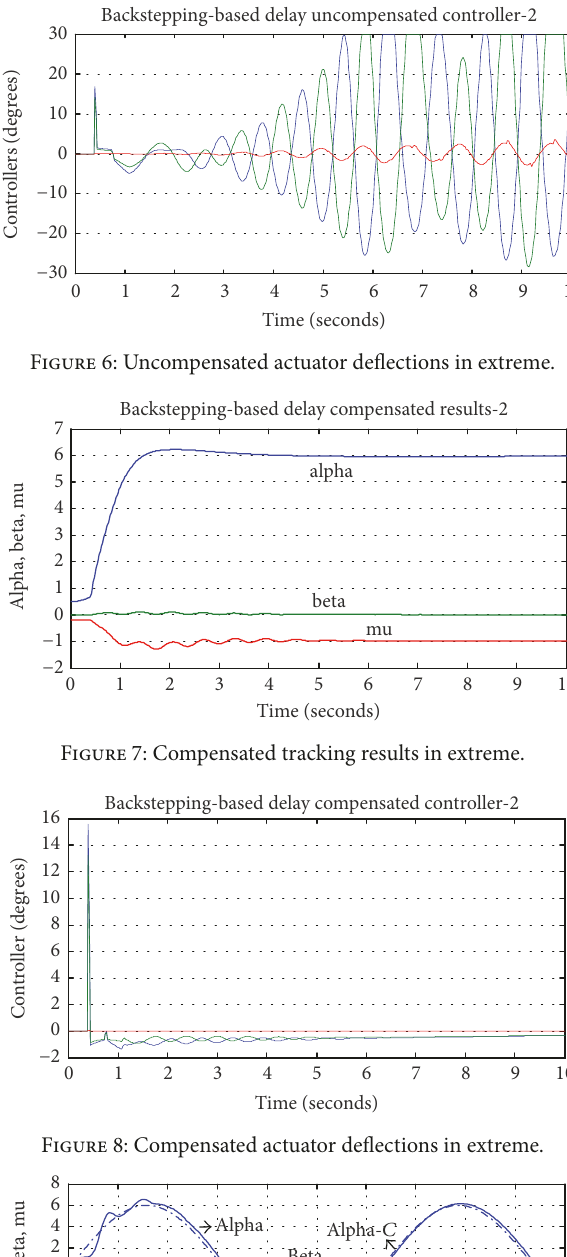
Figure 13: Disturbance observer errors in angles